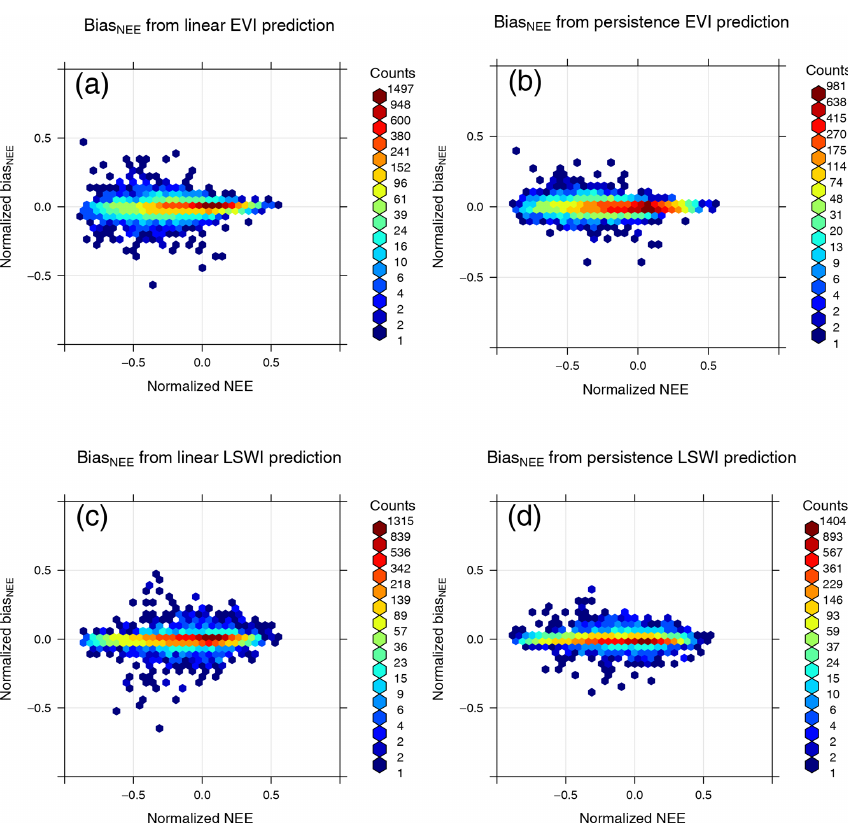
Figure 5. Bias NEE distribution of using linear extrapolation or persistence to predict EVI and LSWI. The persistence prediction introduces less bias than linear extrapolation for both EVI and LSWI. Therefore, persistence is used in the final